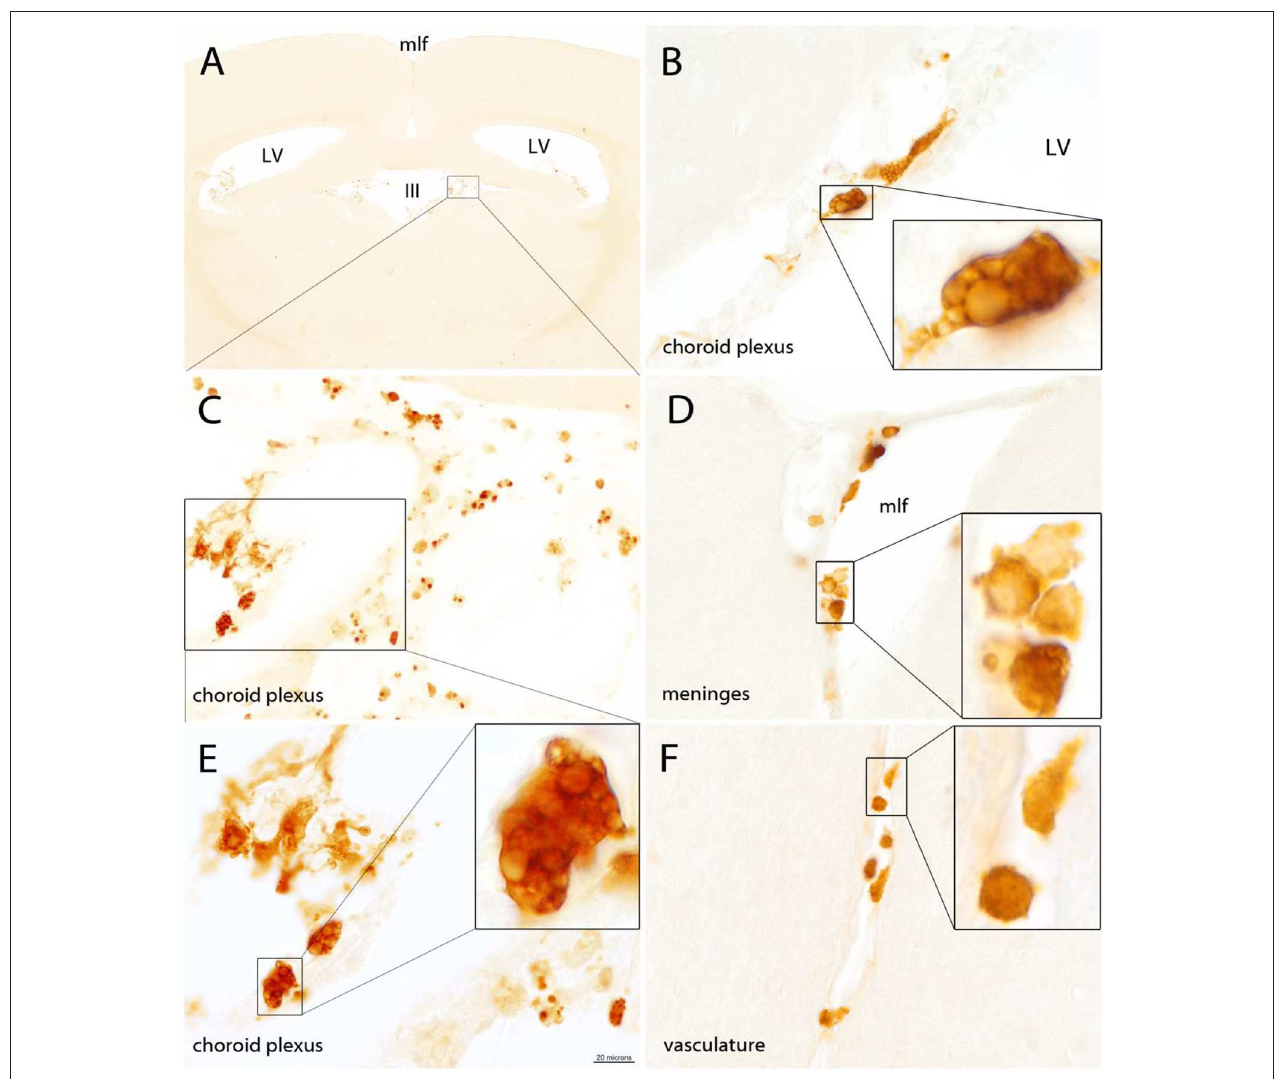
FIGURE 2 | The gerbil brain is shown stained for Quin 24h after IP injection of PWM (500 µ g). No Quin-IR cells were observed within the brain parenchyma (A) . The majority of Quin-IR cells were found in the choroid plexus (B,C,E) . Additional Quin-IR cells were observed in the meninges, for example, at the apex of the medial longitudinal fissure (D) . Quin-IR cells were also observed adherent to the interior surfaces of the brain vasculature (F) . Quin-IR cells ranged widely in morphology, and some appeared relatively unstained but contained Quin-IR phagosomes, which may have been phagocytized debris from apoptotic cells. Others appeared similar to so-called “foam cells,” which are activated macrophages filled with lipid-containing vesicles (insets in B,E ). Bar in (E) , 320 µ m in (A) , 40 µ m in (C) , 20 µ m in (B,D,E,F) , and 6 µ m in the insets. III, third ventricle; LV, lateral ventricles; mlf, medial longitudinal fissure.